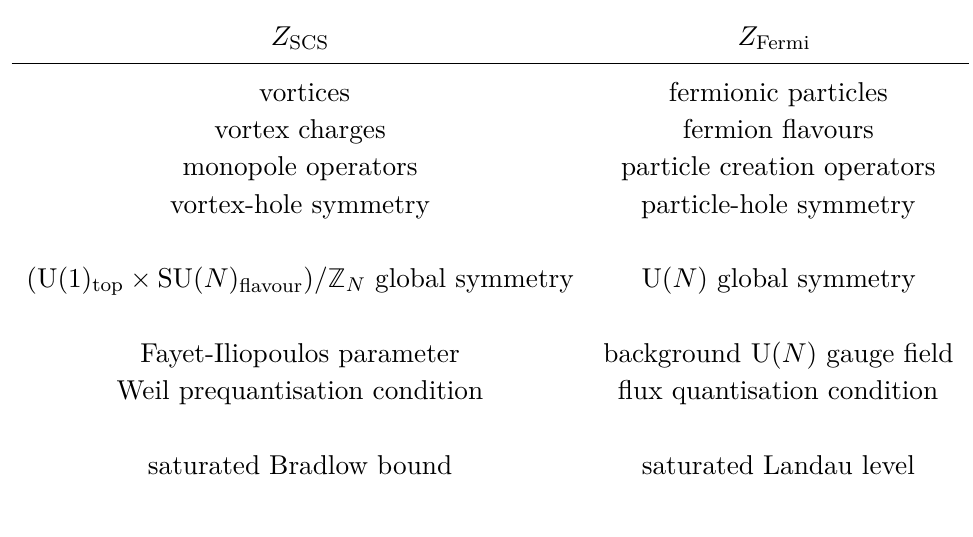
Table 1. A summary of the local Fermi-vortex